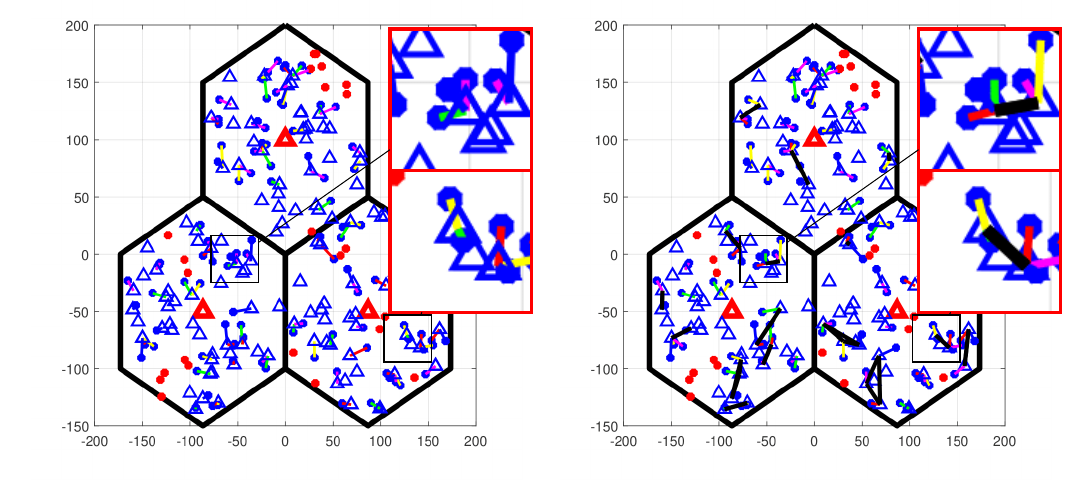
Figure 4. A typical triple-macrocell UDN after SCA with traditional and game-based clustering. Red triangles denote MBSs; red dots are MUEs; blue triangles are SCDs; blue dots are SUEs; SCDs in the same cluster are connected by black straight lines; SUEs served in the same subchannel are connected with their primal SCDs by the same color straight lines.